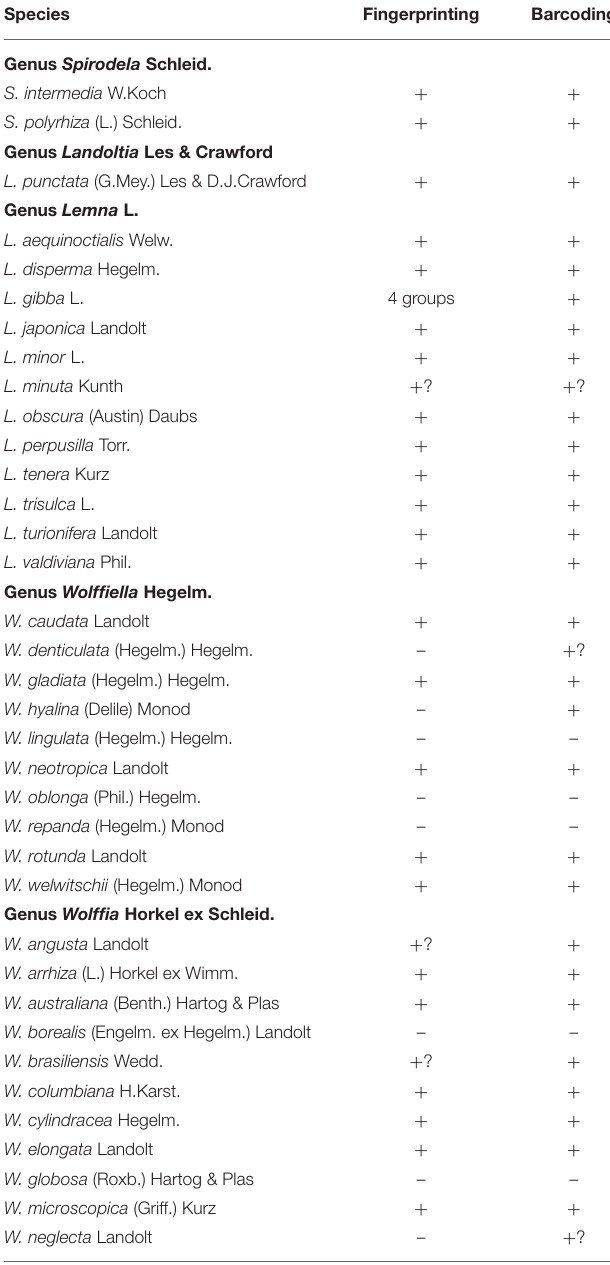
TABLE 1 | Summary of the results of species identification by fingerprinting (AFLP) and barcoding by several plastidic fragments of 36 species of the family Lemnaceae Dumort. Species Fingerprinting